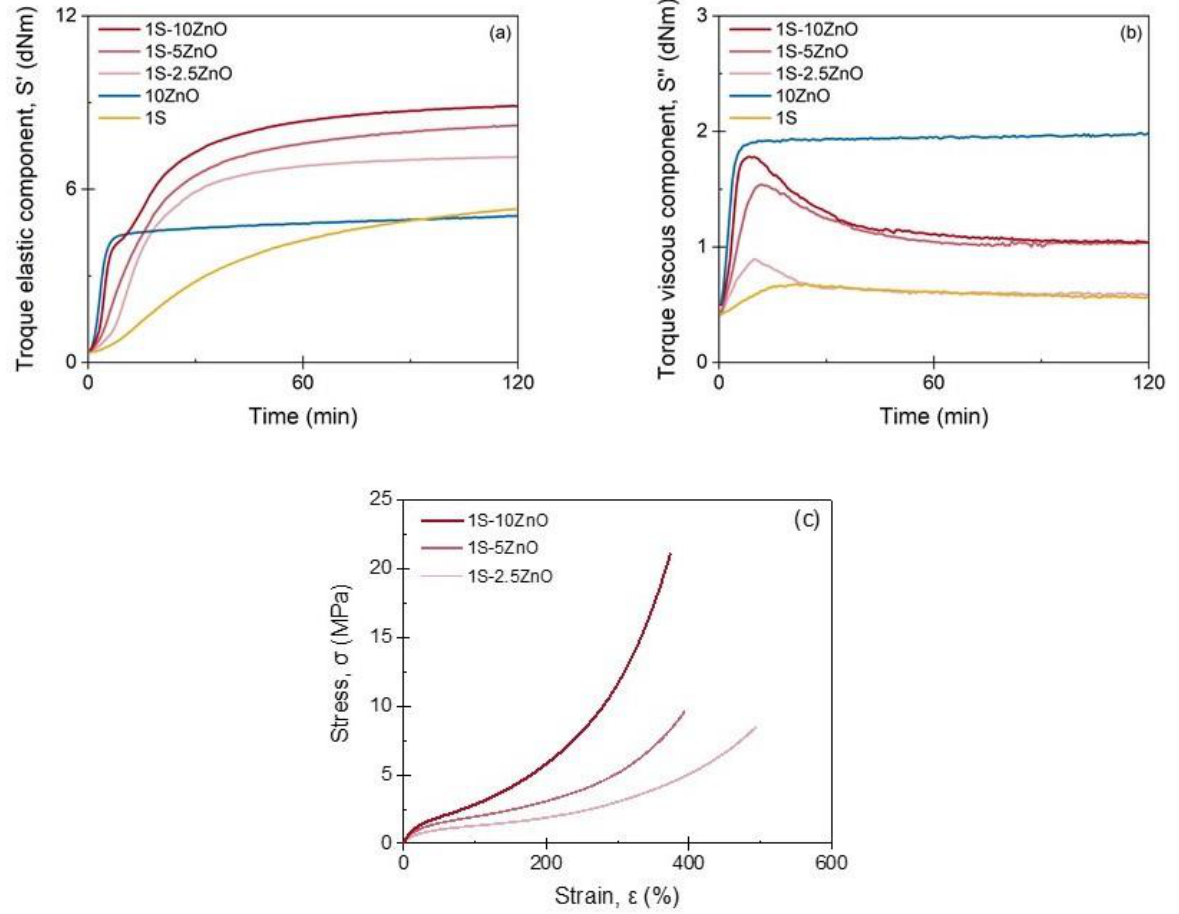
Figure 4. Torque ( a ) elastic and ( b ) viscous components of dual networks compounds (curing curves); ( c ) stress–strain curves of dual networks’ compounds.